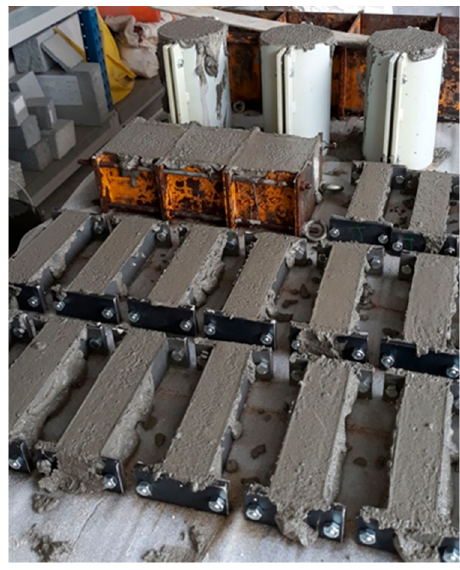
Figure 7. Plaster specimens prepared for physical-mechanical tests, according to standard UNI EN 998-1 and 2. Table 6. Standardized f tests carried out on the eco-plaster product. n.d is not defined.